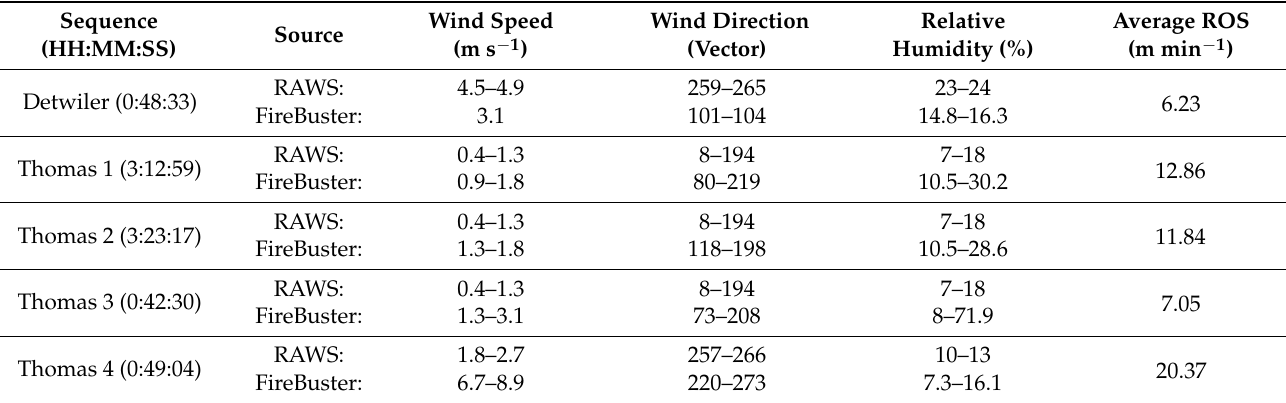
Table 3. Remote Access Weather Station (RAWS) and FireBuster weather reports by fire and rate of spread (ROS) sequence. Weather attributes depict data range reported during airborne thermal infrared (ATIR) image collection periods. The elapsed time of ATIR imaging is included in sequence headings. Average reported ROS derived from landscape sampling units.